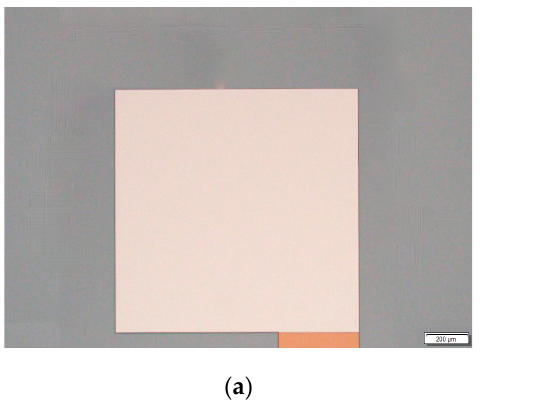
Figure 7. Optical images of TFTC pads. ( a ) Before 620 °C; ( b ) After 620 °C. After testing, the surface of the pads becomes burnt black from the yellow before testing, and the dense film on the surface of the pads becomes a layer of powder-like par- ticles. The resistance of TFTC before the test is 178 Ω , but exceeds the range of the test at about 620 °C, resulting in no electrical response.